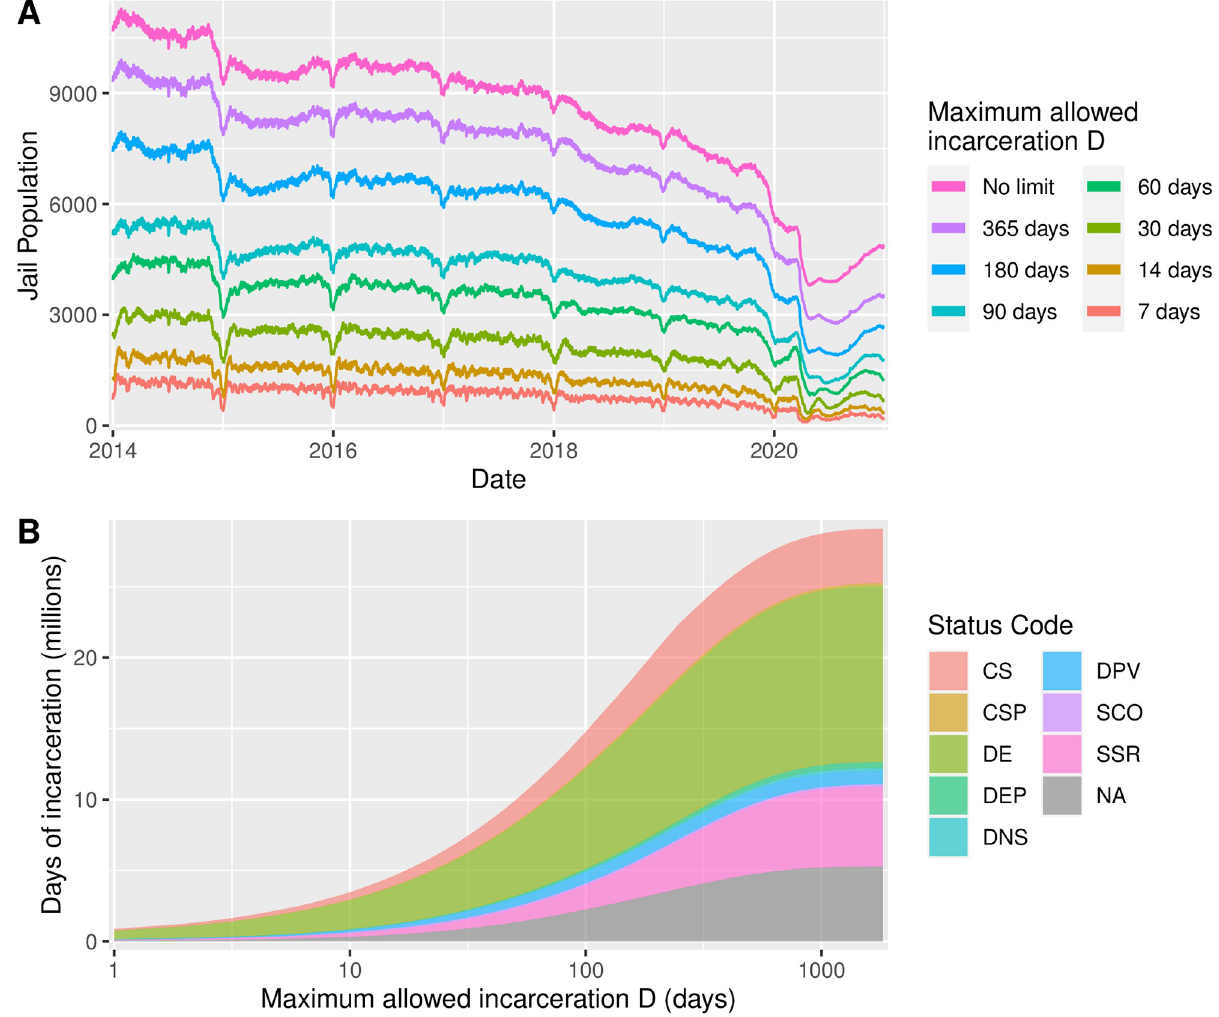
Fig 4. Effect on historical jail population of hypothetical incarceration caps in New York City, 2014–2020. (A) Time series of the jail population for several values of the incarceration cap D . The top curve (pink) represents the true historical jail population. (B) Effect of incarceration cap on the